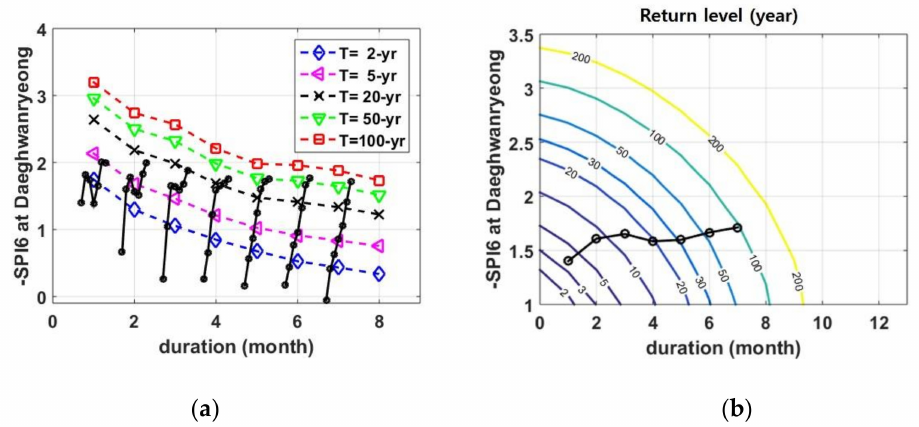
Figure 8. Drought situation monitoring using SDF curves based on ( a ) partial duration series and ( b ) bivariate exponential